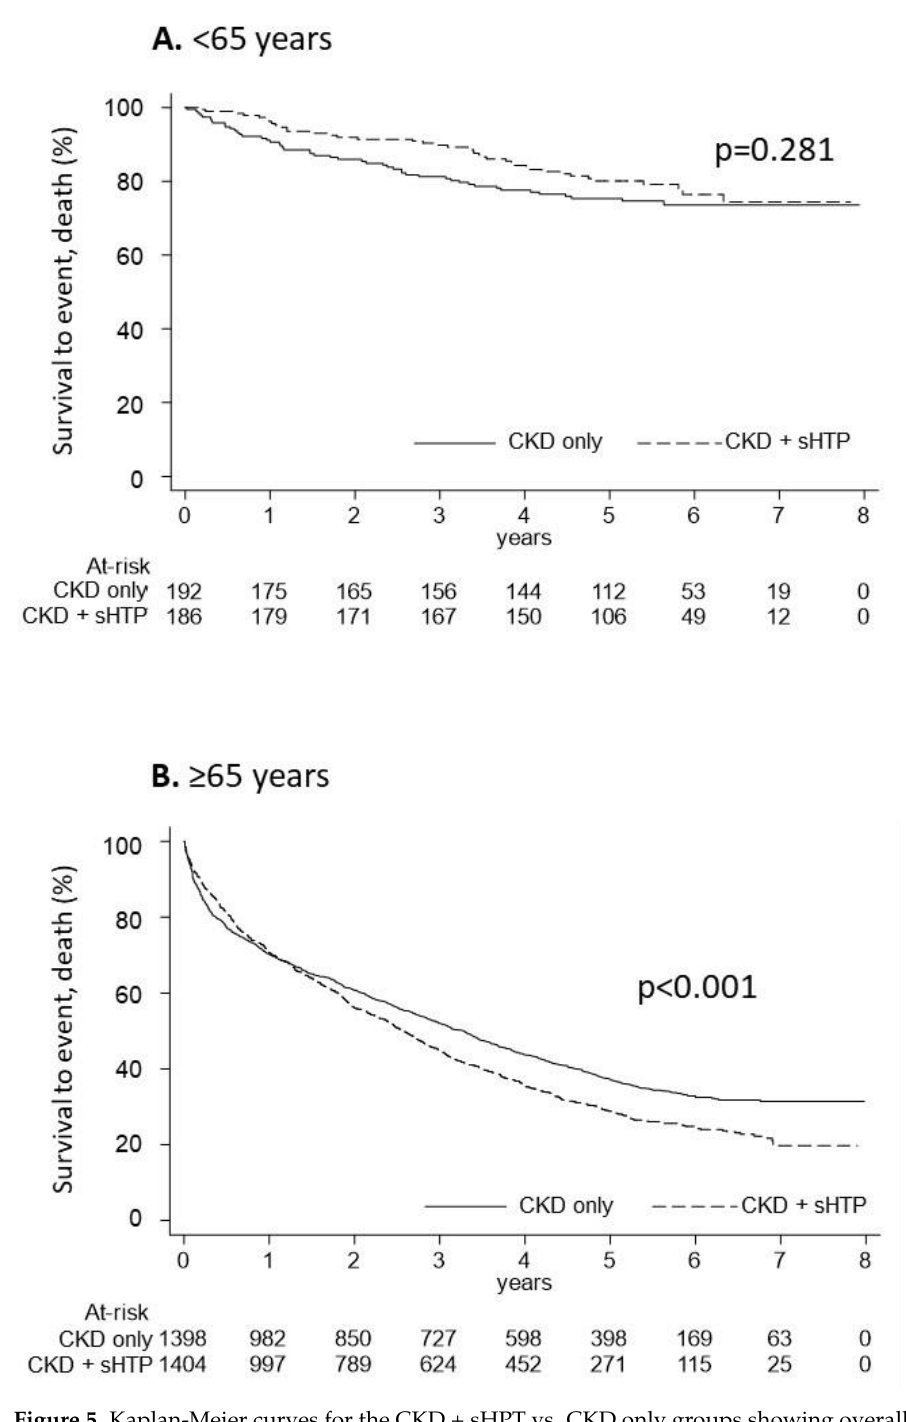
Figure 5. Kaplan-Meier curves for the CKD + sHPT vs. CKD only groups showing overall survival in CKD patients aged < 65 years ( A ) and in those aged ≥ 65 years ( B ). Regardless of the vitamin D treatment (NVD, AVD, and analogues), CKD + sHPT patients were subgrouped into those treated or untreated if they presented or not at least one prescription of AVDs and/or NVDs during all available periods. The treated and untreated cohorts were balanced using PSM, and their baseline characteristics are reported in Table 2.